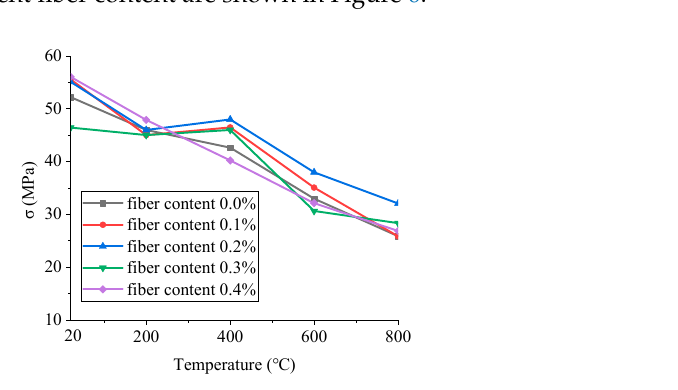
Figure 6. Temperature effect on the dynamic peak stress of BFRC specimens with different fiber contents.